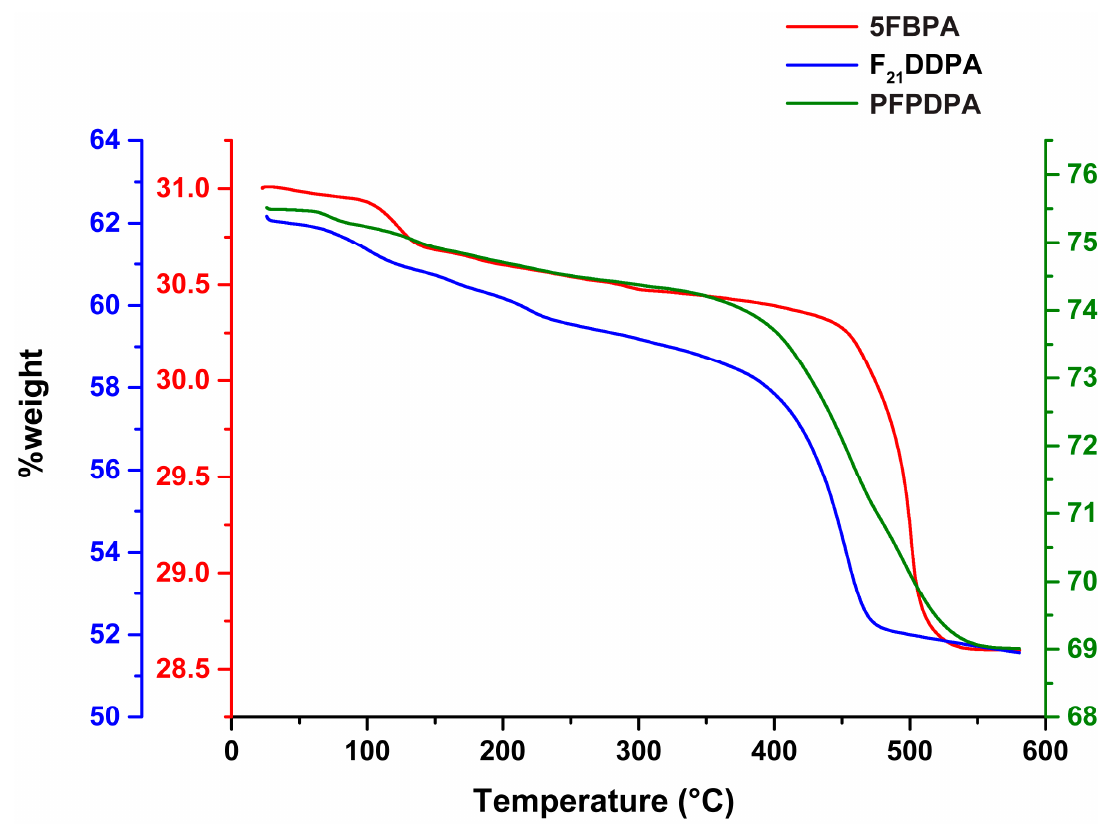
Figure 7. Thermogravimetric analysis (TGA) data analysis of surface modifications with the 5FBPA (red line and y -axis), F 21 DDPA (blue line and y- axis), and PFPDPA (green line and y -axis) modifications on ZnO nanoparticles.